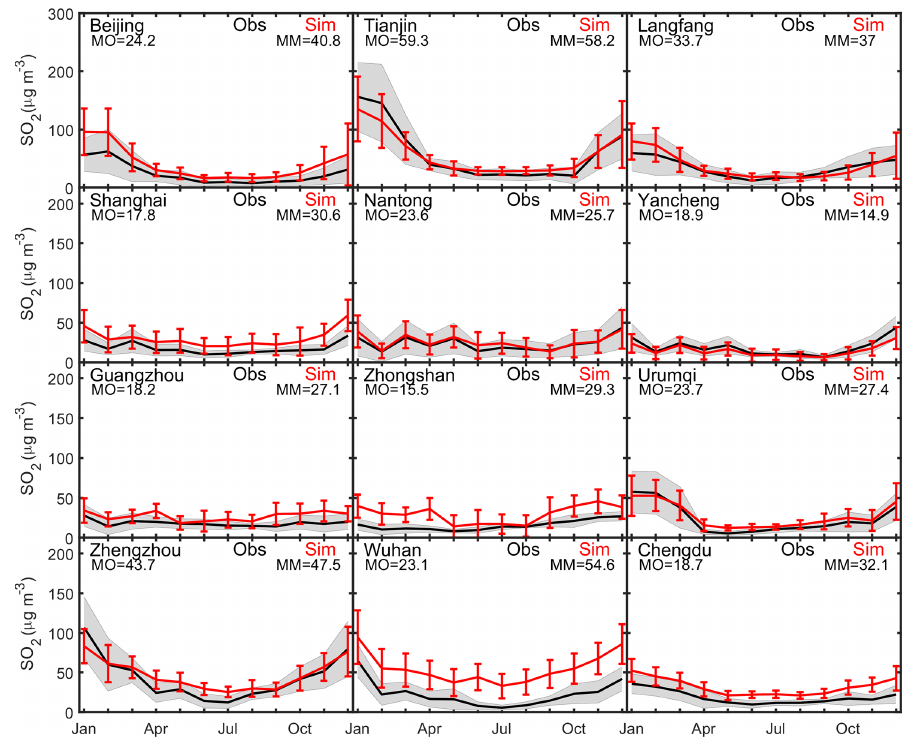
Figure 13. Mean seasonal variation of SO 2 (µgm − 3 ) over China. The black and red lines represent the monthly mean concentration of the city-averaged observations and simulation respectively. Gray shaded areas and red vertical bars show ± 1 standard deviation over the sites for the observations and for model results respectively. MO and MM represent the annual mean concentration of the observations and simulation